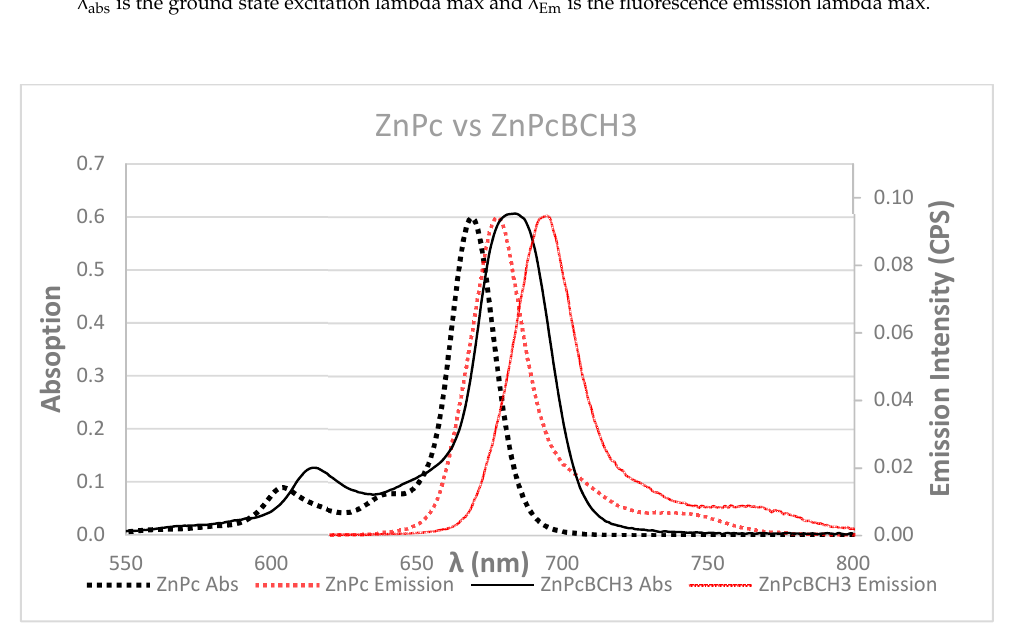
Table 2. Absorption data recorded in DMF.